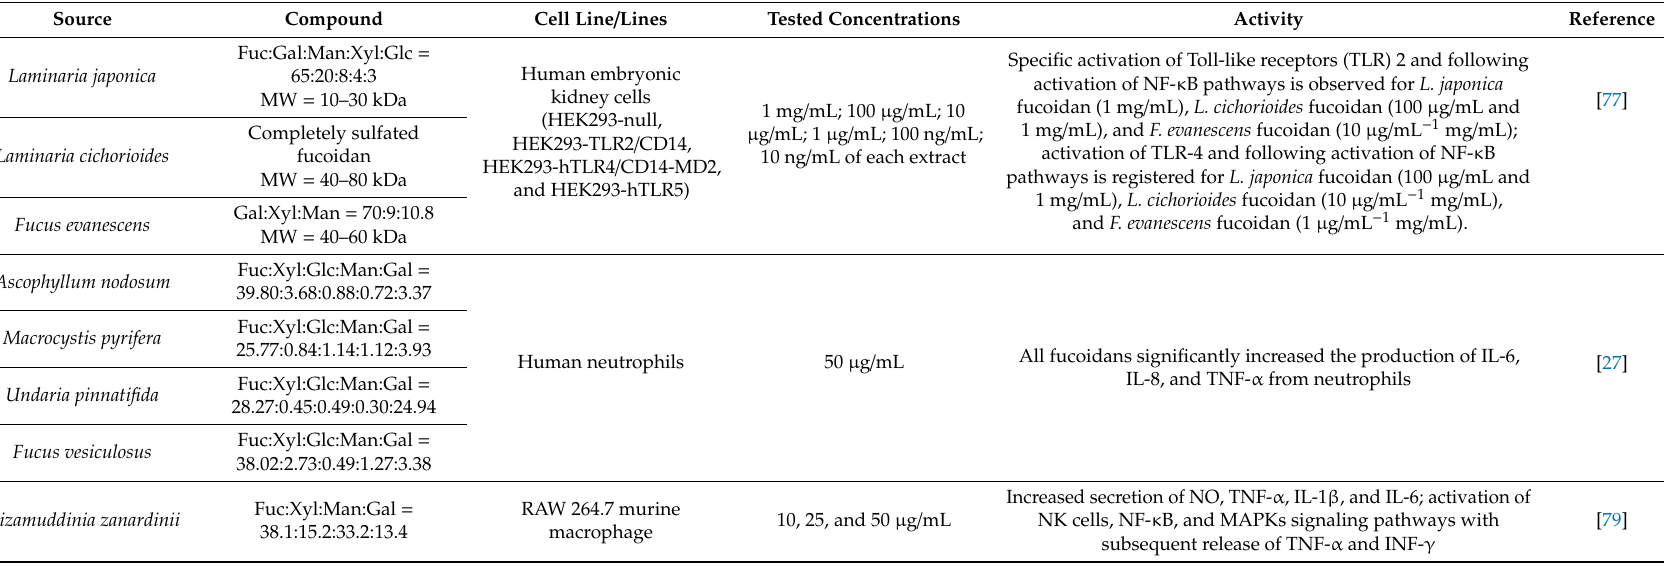
Table 3. In vitro immunomodulatory activity of